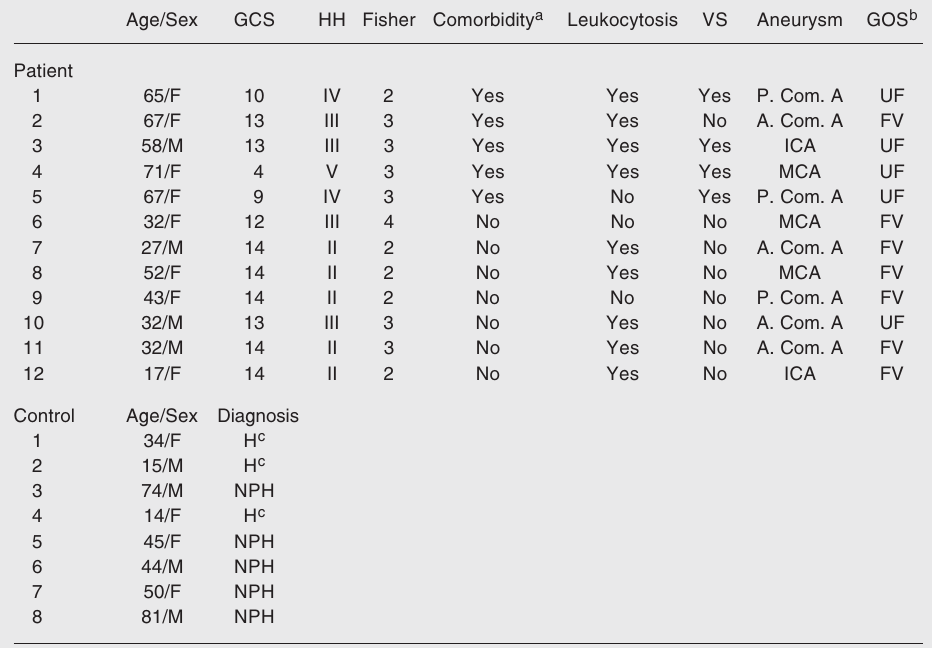
Table 1. Clinical data of the patients with subarachnoid hemorrhage and hydrocephalus controls. Age/Sex